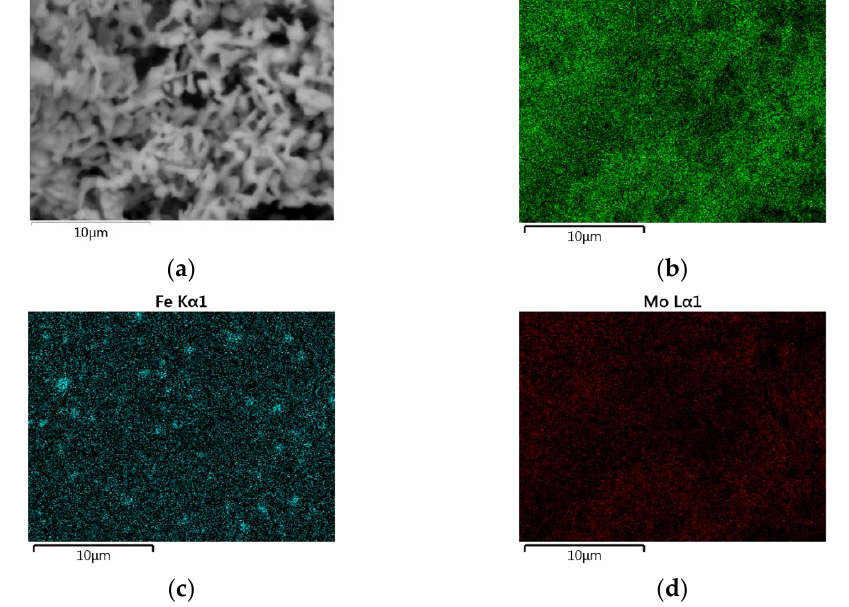
Figure 7. EDS mapping for a section of the sample SGB after the reduction process ( a ). A uniform distribution of strontium ( b ) and molybdenum ( d ) atoms can be observed while a non-uniform distribution of iron ( c ) atoms is obtained.